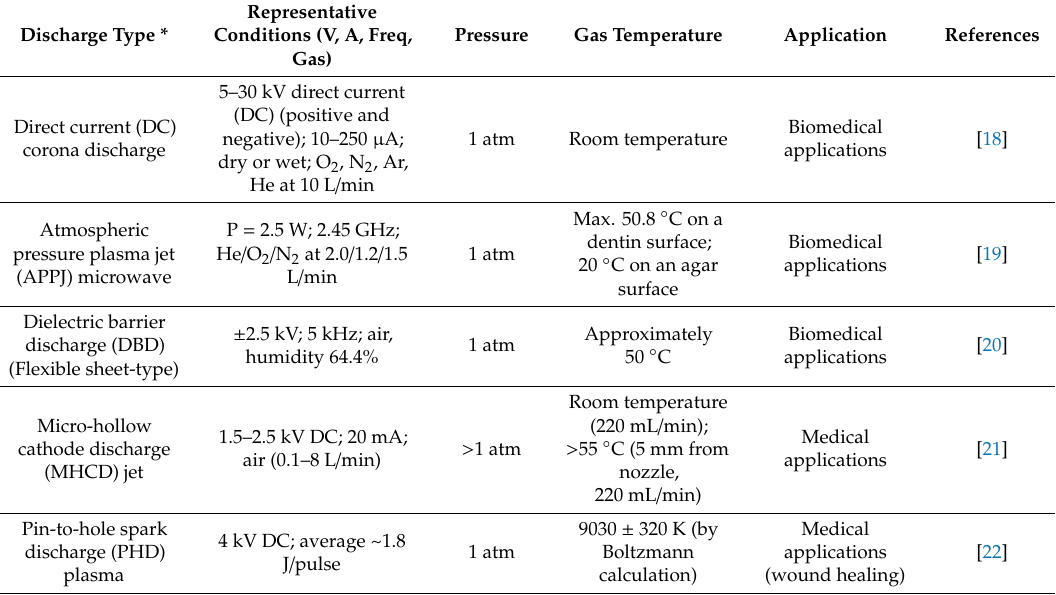
Table 2. Various types of electrical discharge methods for non-thermal plasma